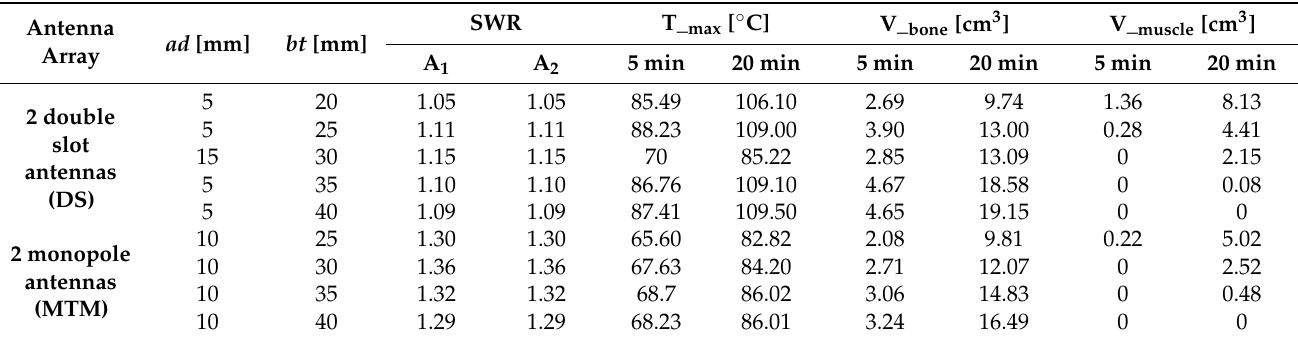
Table 3. Linear antenna array performance. Best-case scenarios were obtained for each analyzed bone thickness ( bt ) based on the SWR of the antennas. Maximum reached temperature and tissue volume at temperatures higher than 55 ◦ C are presented.